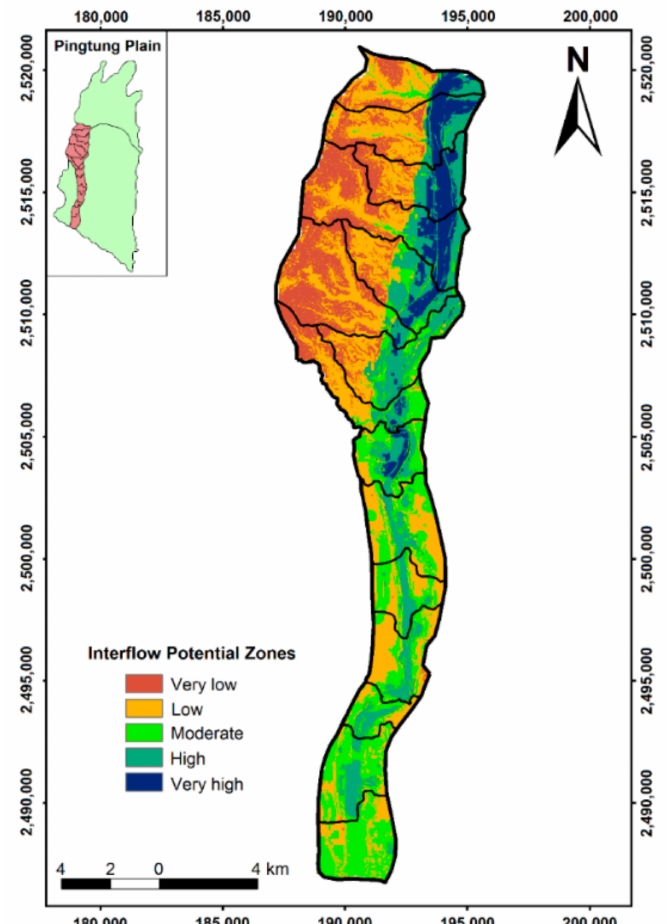
Figure 6. The interflow potential map was developed based on the index-overlay method. The ratings and weightings are determined by the AHP